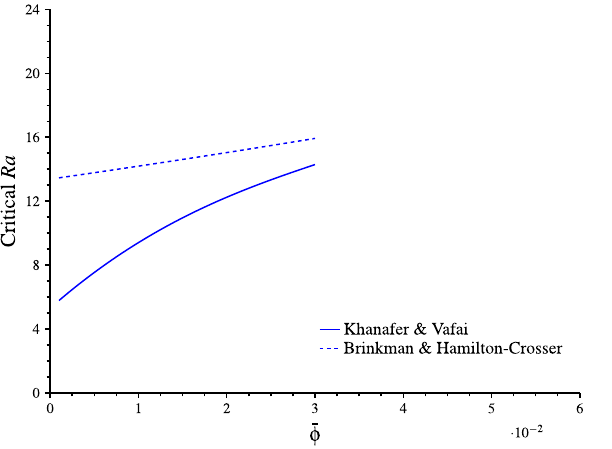
Figure 3: The relation between the volume fraction of nanoparticles and the critical thermal Rayleigh number for a DW/alumina nano fl uid based on the model of Khanafer and Vafai and the model of Brinkman and Hamilton -